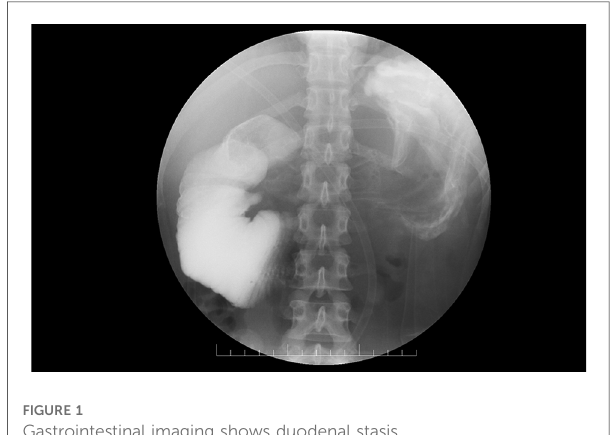
FIGURE 1 Gastrointestinal imaging shows duodenal stasis.